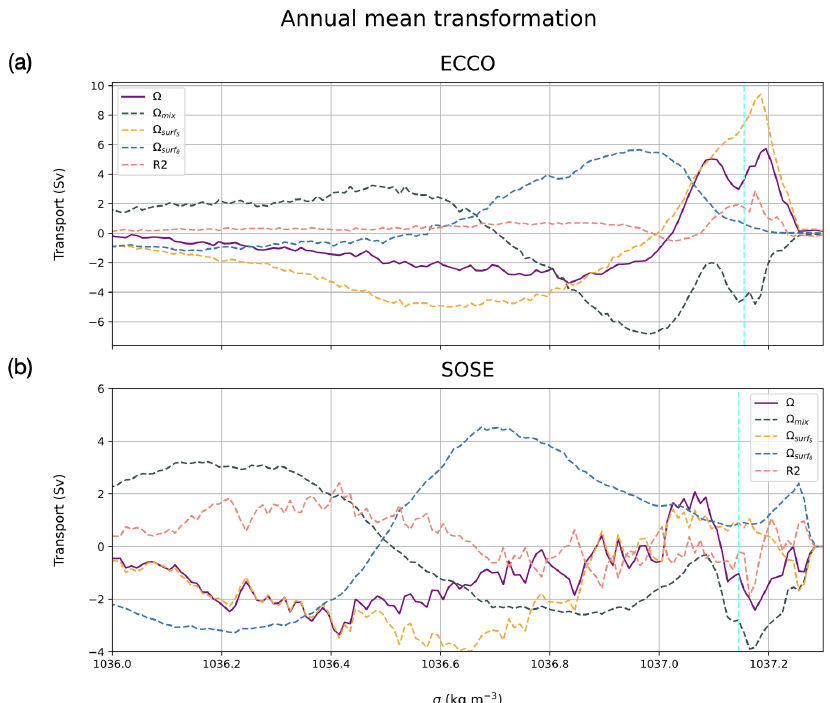
Figure 6. (a) Transformation term, (cid:127) (solid purple line), broken down into its sources of transformation: surface salt flux (orange dashed line), surface heat flux (blue dashed line) and mixing (slate-grey dashed line). Residual due to numerical mixing is the pink dashed line in ECCO (a) and SOSE (b) . The vertical dashed line demarcates the boundary of bottom water in each model (1037.155kgm − 3 for ECCO, 1037.145 for SOSE and 1037.175kgm − 3 for